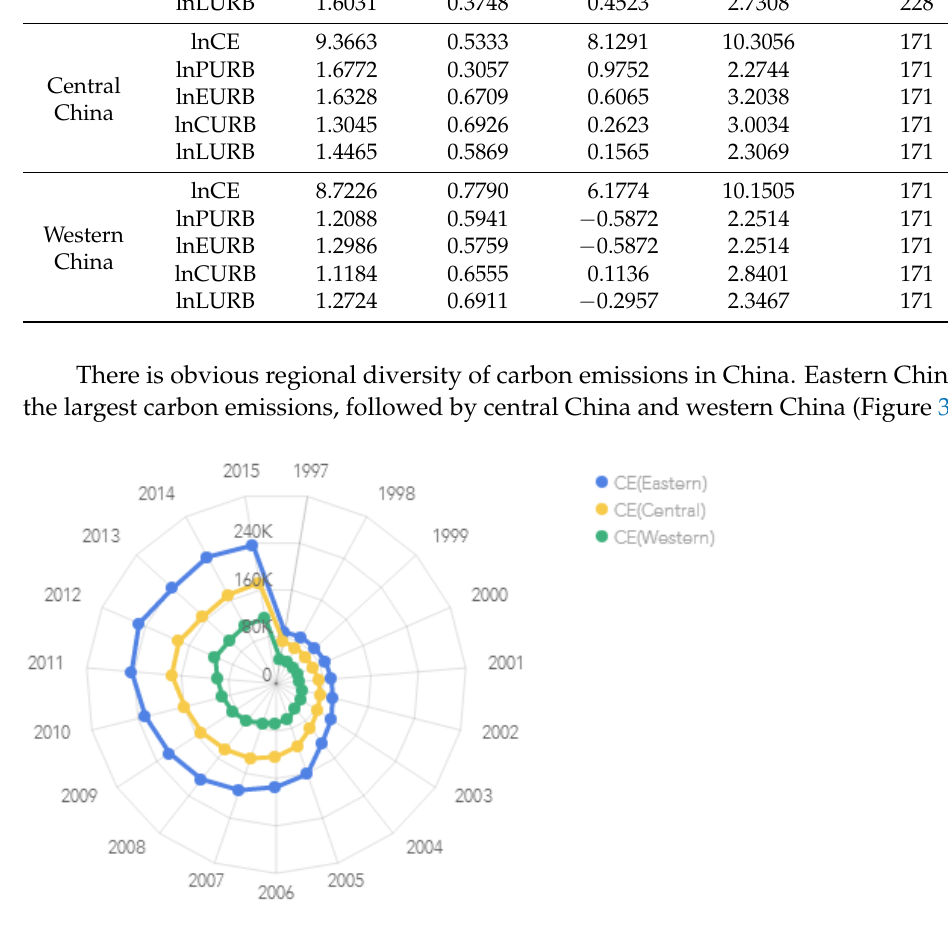
Figure 3. Carbon emissions of eastern, central, and western China from 1997 to 2015 (Unit: 10,000 tons).